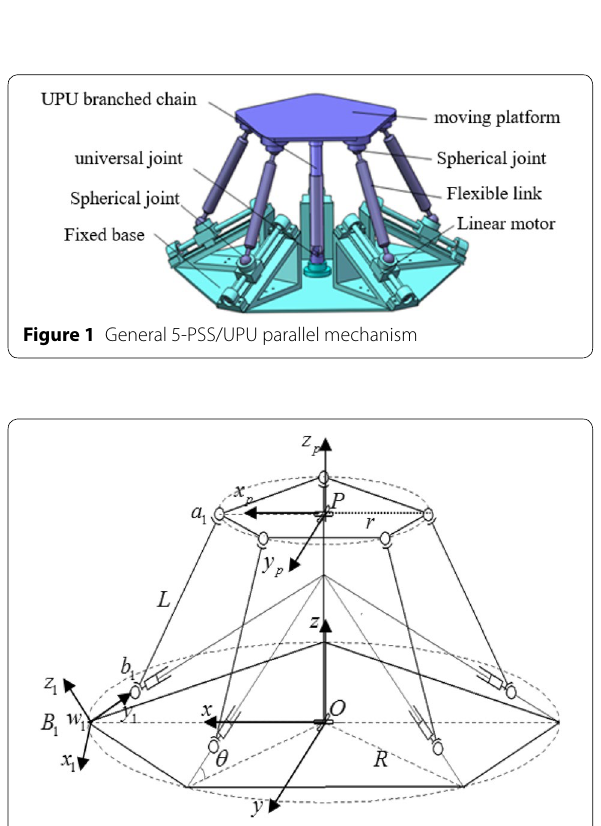
Figure 2 Sketch of 5-PSS/UPU parallel